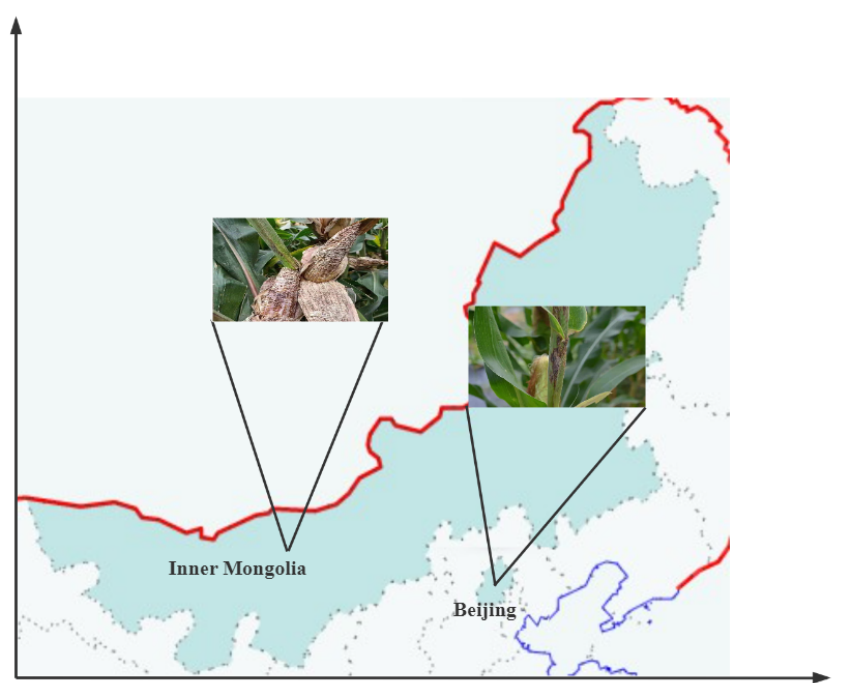
Figure 1. Datasets were collected at two experimental sites, which were from Science Park in the west campus of China Agriculture University ( right ) and Vocational and Technical College of Inner Mongolia Agricultural University ( left ).